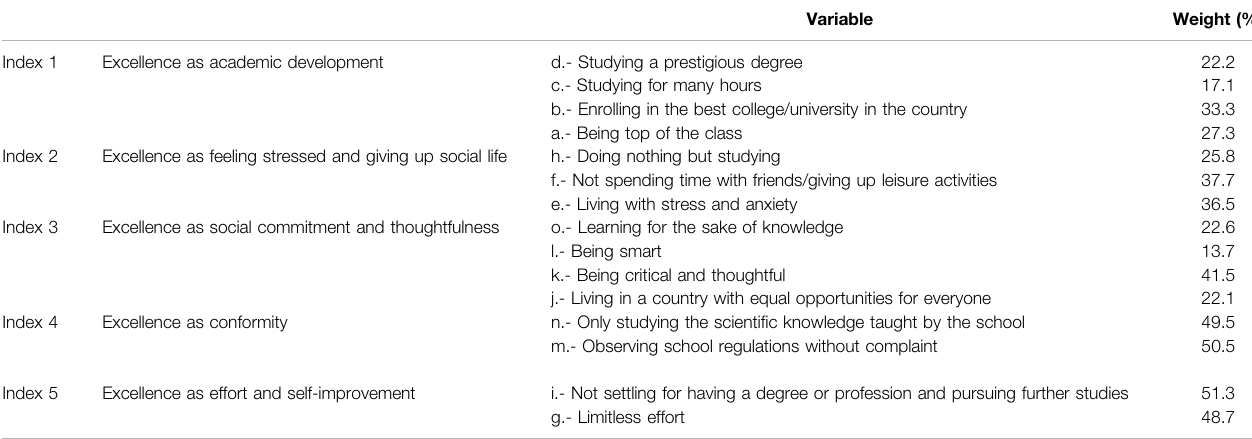
TABLE 2 | Estimated weights for indices related to notions of excellence.